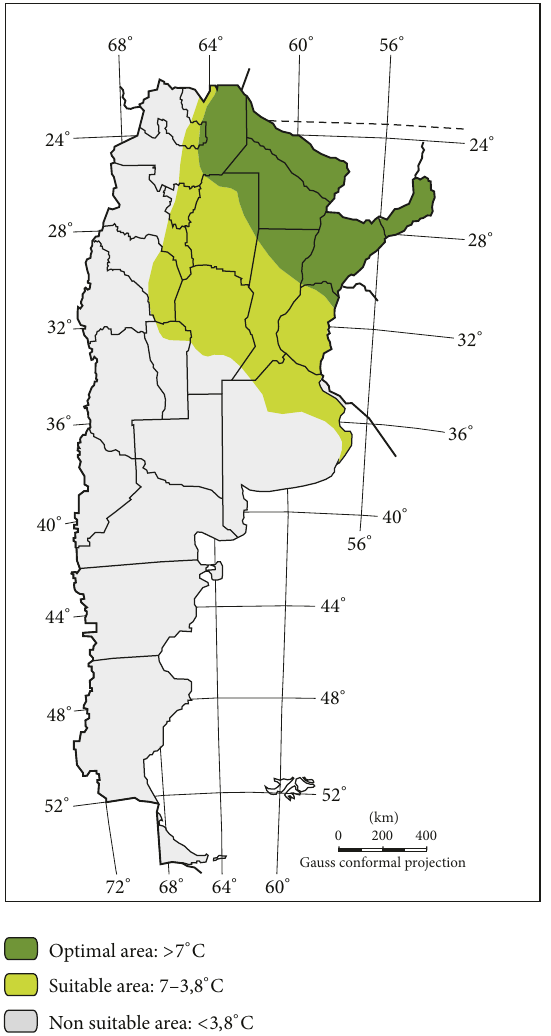
Figure 7: Minimum temperature of coldest month. Figure 8: Mean annual minimum